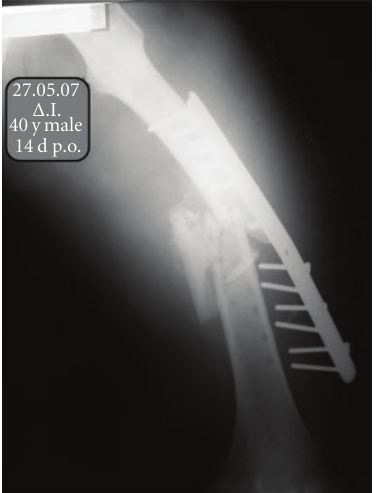
Figure 1: Mechanical failure of the initial internal fixation two weeks postoperatively.